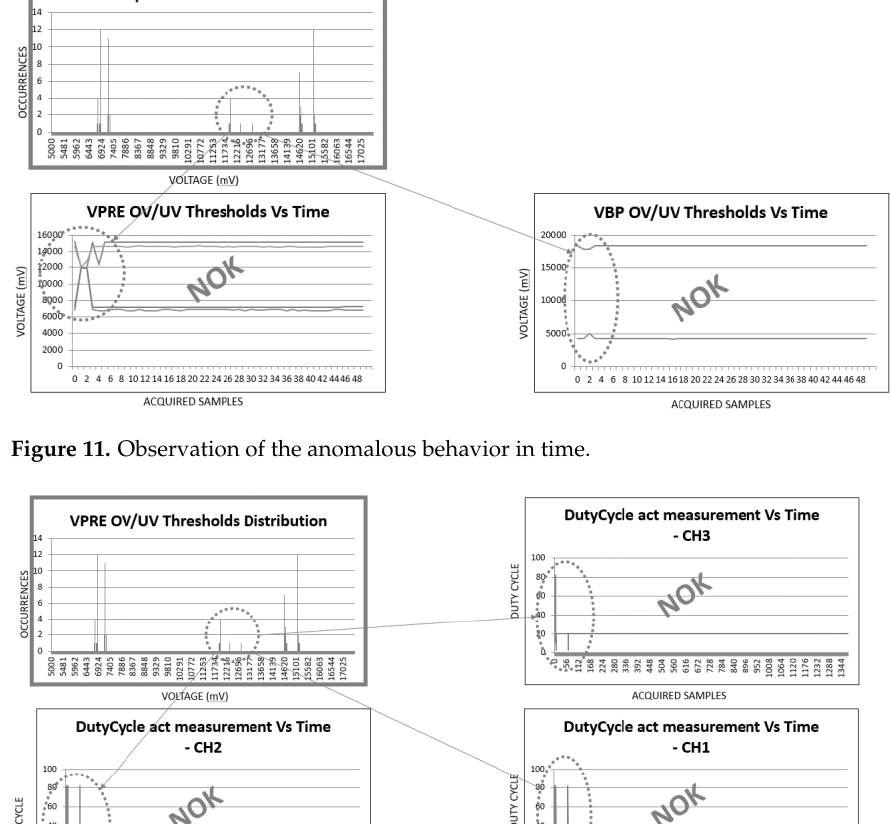
Figure 12. Correlating the anomalies to other parameters.